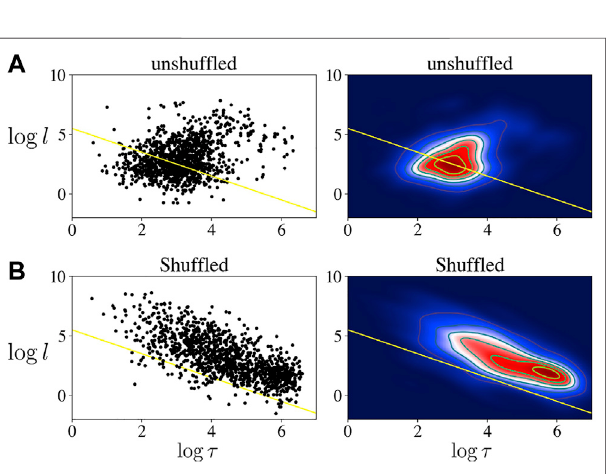
FIGURE 4 | Density plots of the set n * represented in log τ -log l space. (A) Result for the original KSMMA catalog. (B) Result for the shuf fl ed KSMMA catalog. Here, we used the shuf fl ed catalog to estimate n *, shown as a yellow linethatseparates thetwopopulations oftriggeredevents below theline and background events above the